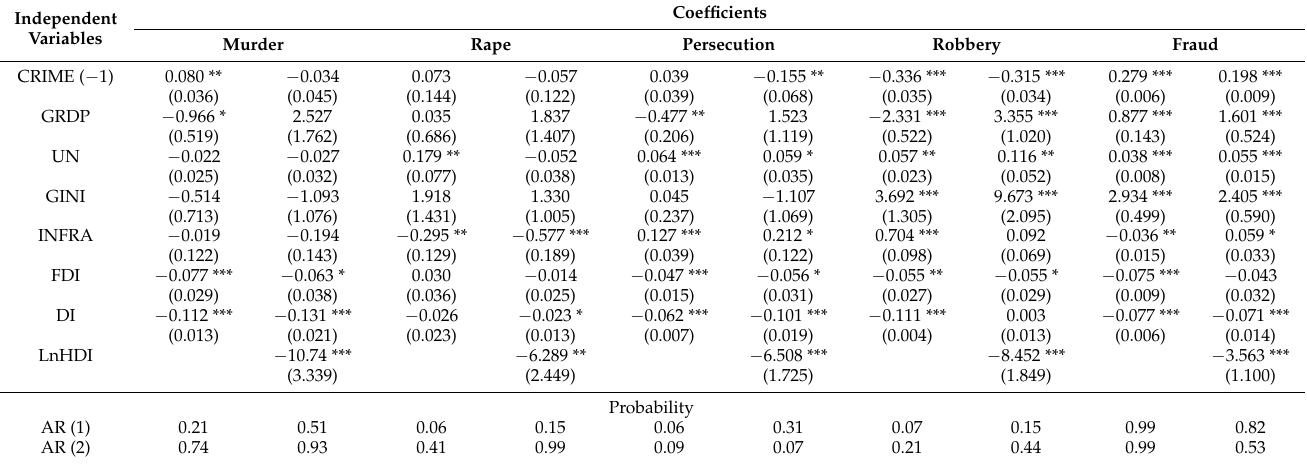
Table 4. GMM estimation result by criminal